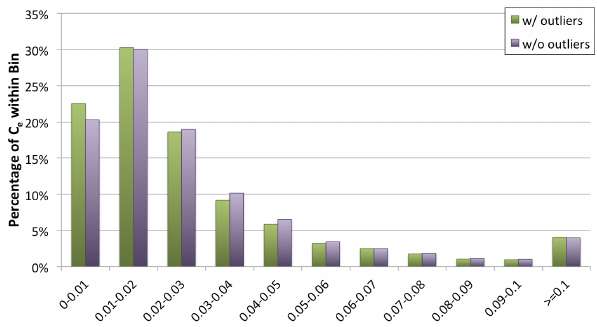
Figure 6. Percentages of binned C e values from all scatter plots Fig. 6. Percentages of binned C e values from all scatterplots based on Aqua-MODIS data 1531 based on Aqua-MODIS data and the 11300 filter (see Tables 1, 2, and the 11300 filter (see tables 1, 2, and 3) before and after outlier removal. C e appears to 1532 and 3) before and after outlier removal. C e appears to have shifted have shifted towards higher values overall. 1533 towards higher values